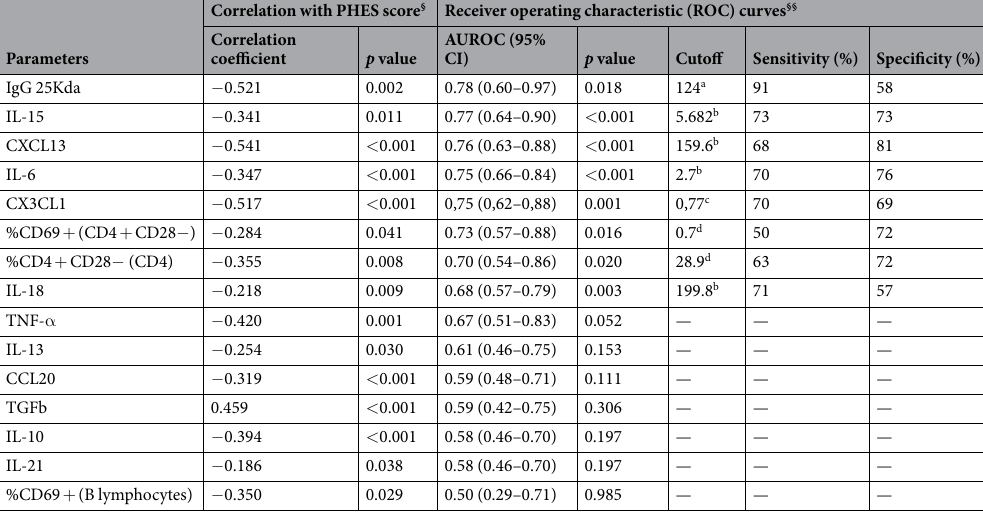
Table 1. Diagnostic accuracy of different variables for detection of MHE. § Spearman’s Rho correlation between parameters and PHES score. §§ Receiver operating characteristic (ROC) curves for sensitivity and specificity of parameters in the diagnosis of minimal hepatic encephalopathy in the cohort of patients. AUROC, area under the receiver operating curve; CI, confidence interval; IL, interleukin; Cutoff: a in % of control, b in pg/mL, c in ng/mL and d in % over cell